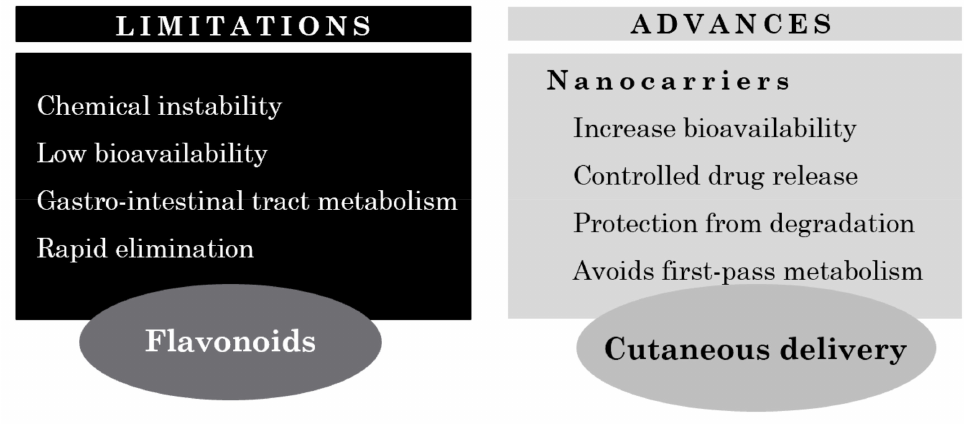
Figure 5. Limitations and advances on cutaneous flavonoid